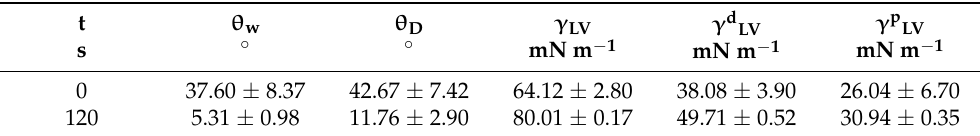
Table 1. Contact angle ( θ ) and surface energy ( γ ), before and after argon plasma pretreatment.